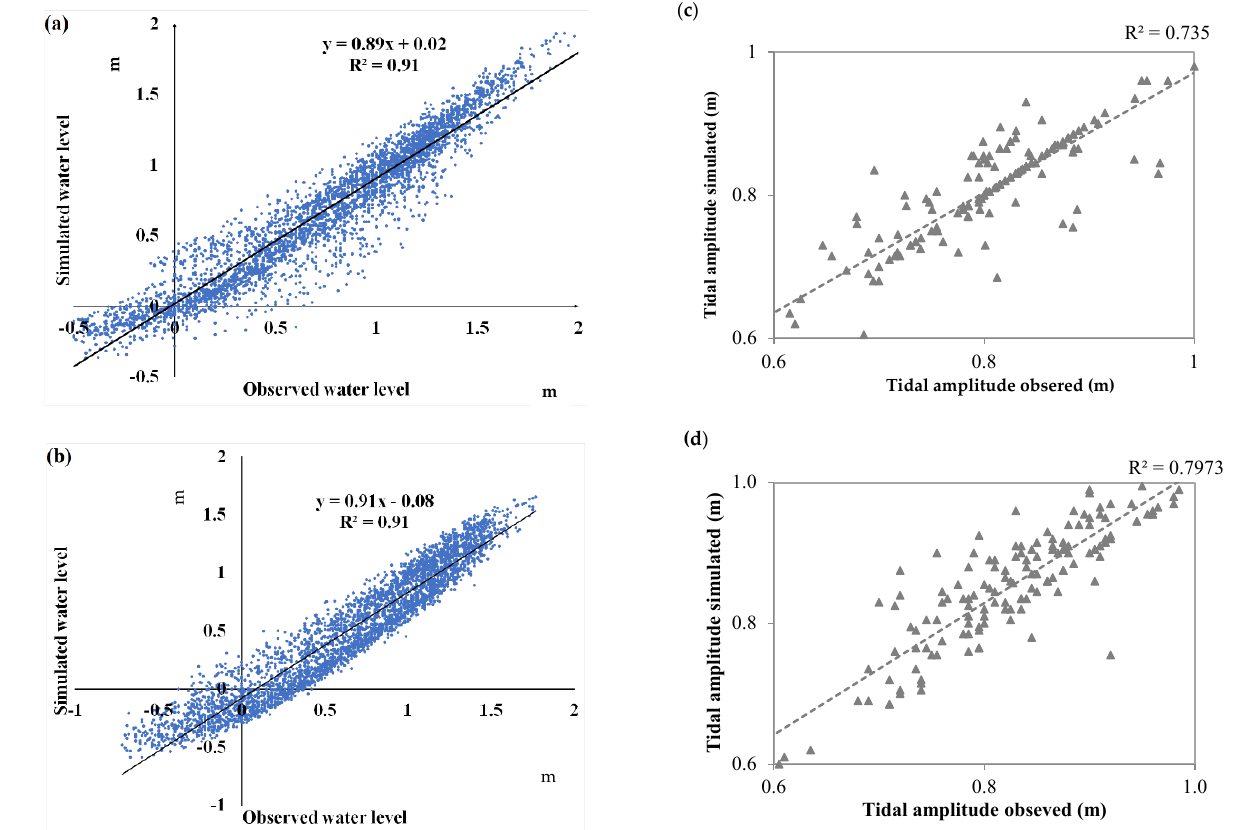
Figure 5. The correlation plots between observed and simulated water level data at an hourly scale for the dry seasons in ( a ) 2019 and ( b ) 2020. The correlation plots between observed and simulated tidal amplitude at a daily scale for the dry seasons in ( c ) 2019 and ( d ) 2020.